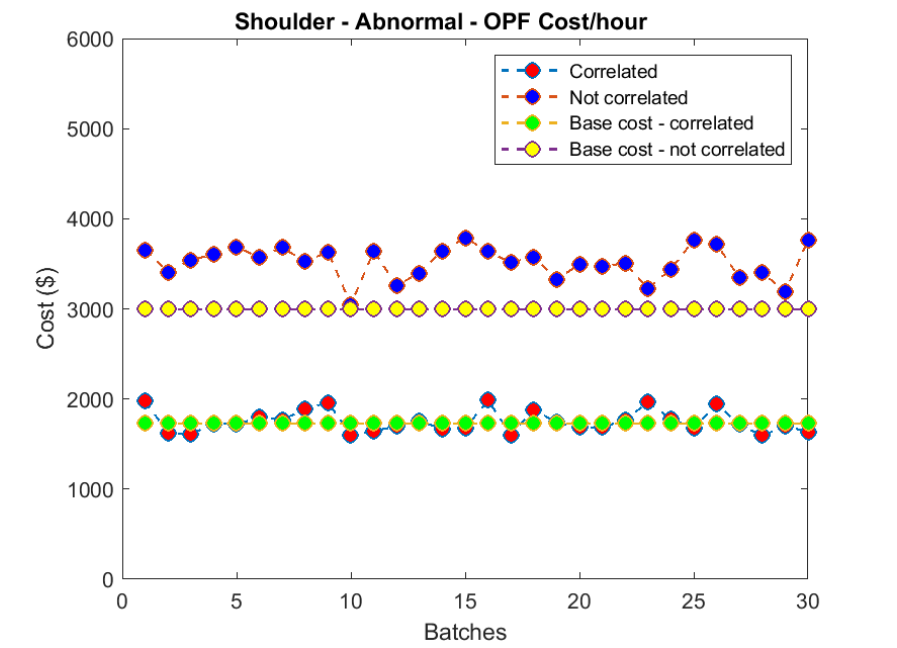
Figure 11. Shoulder abnormal OPF cost (ratio =